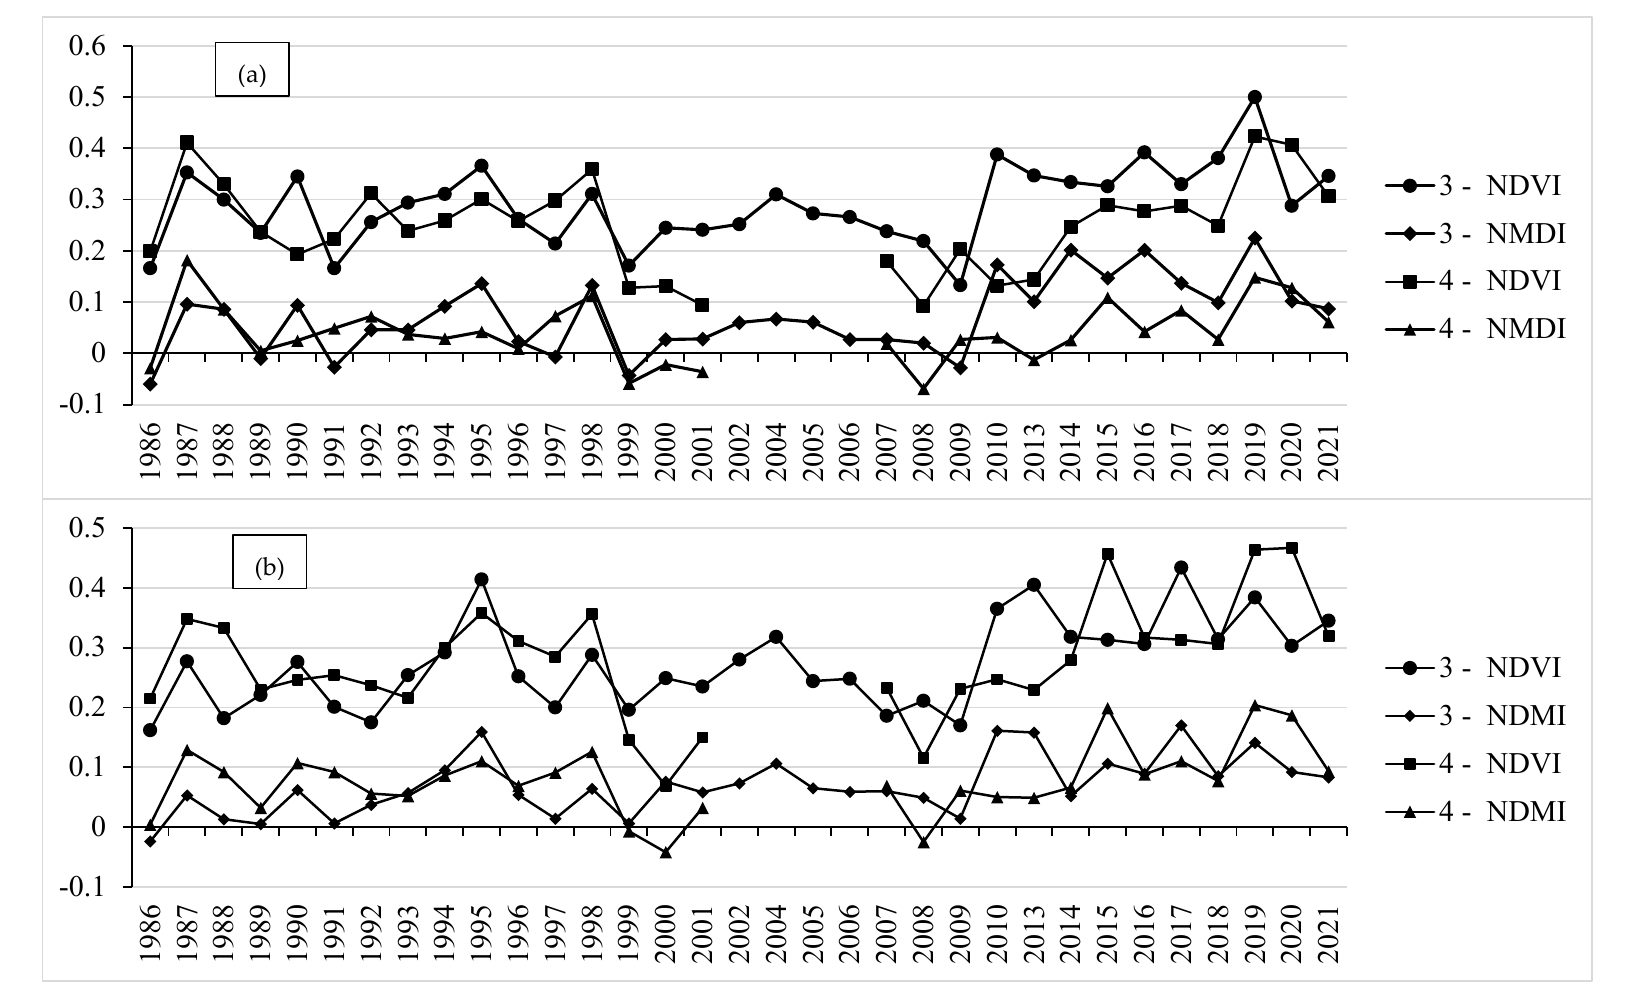
Figure 6. Spatiotemporal phenological profiles of the maximum NDVI and NDMI values in March and April during all growing seasons between 1986 and 2021 in ( a ) Jordanian and ( b ) Syrian parts of YRB.